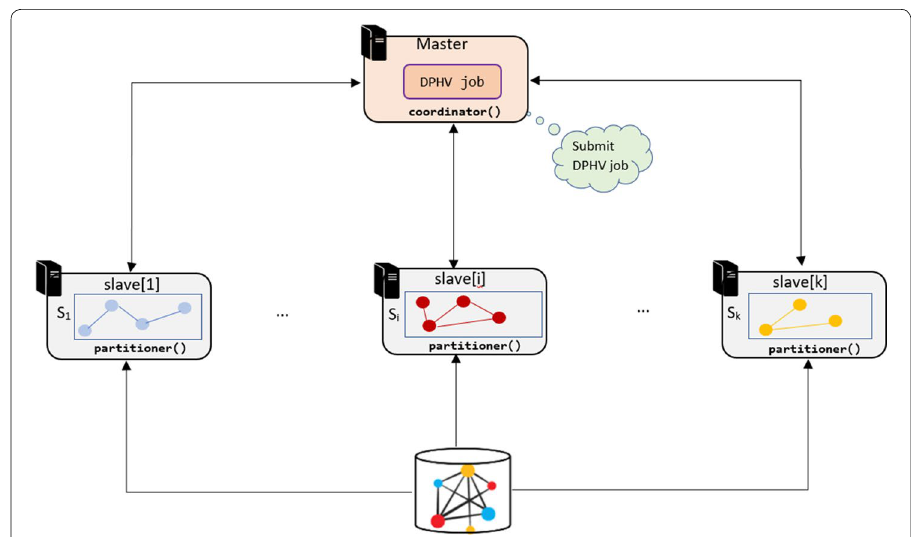
Fig. 6 Overview of the DPHV execution